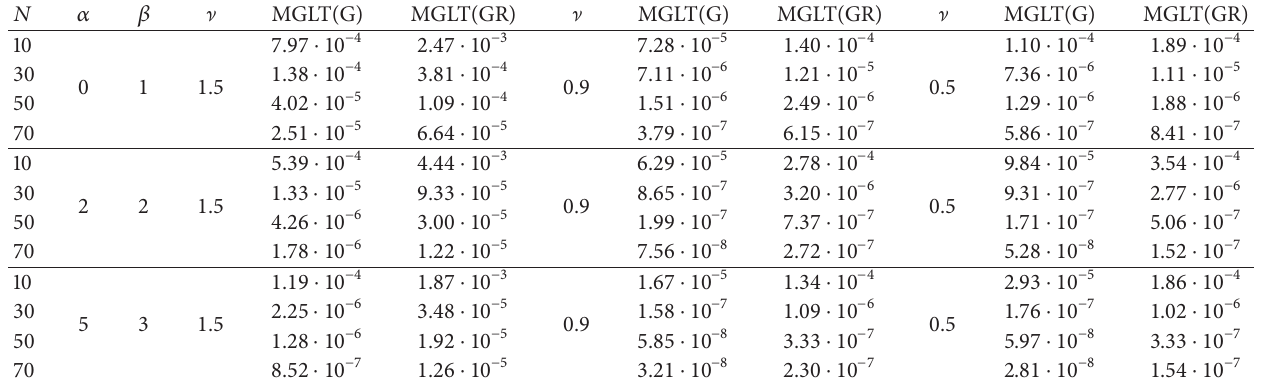
Table 2: Maximum absolute error for 𝛾 = 1/10 , with various choices of 𝑁 , for Example 5 in which 𝑥 ∈ [0, 10] .